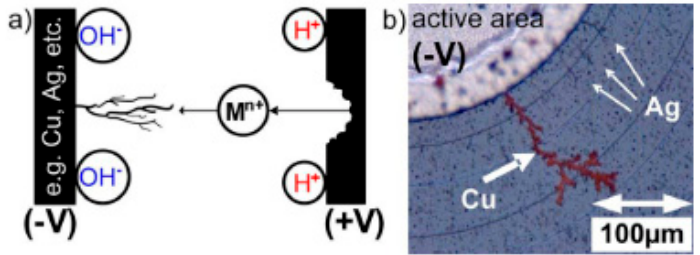
Figure 7. Schematic process of ECM dendrite formation ( a ) and an example of Cu and Ag dendrite formation on the junction termination of a 1.7 kV diode chip after HV-THB testing ( b ). Figure reproduced with permission from [9].